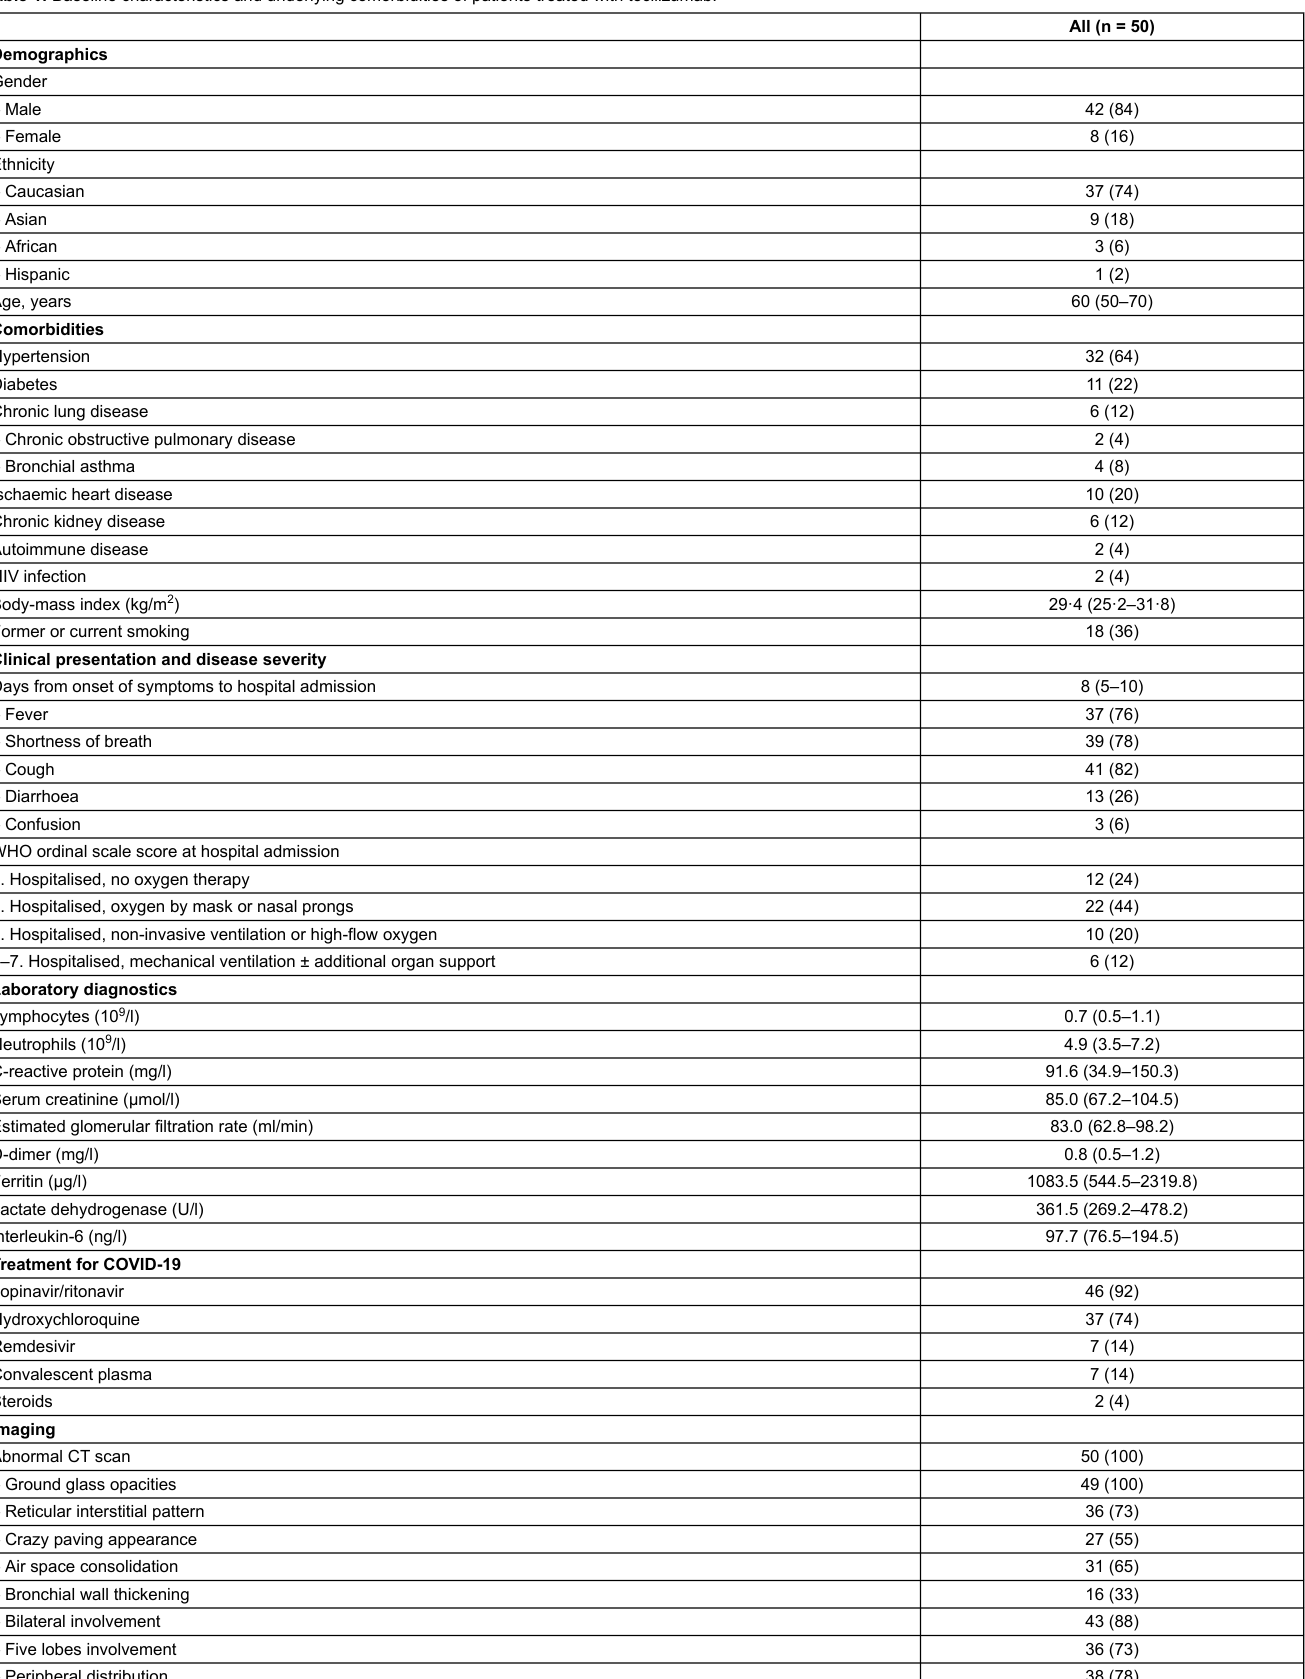
Table 1: Baseline characteristics and underlying comorbidities of patients treated with